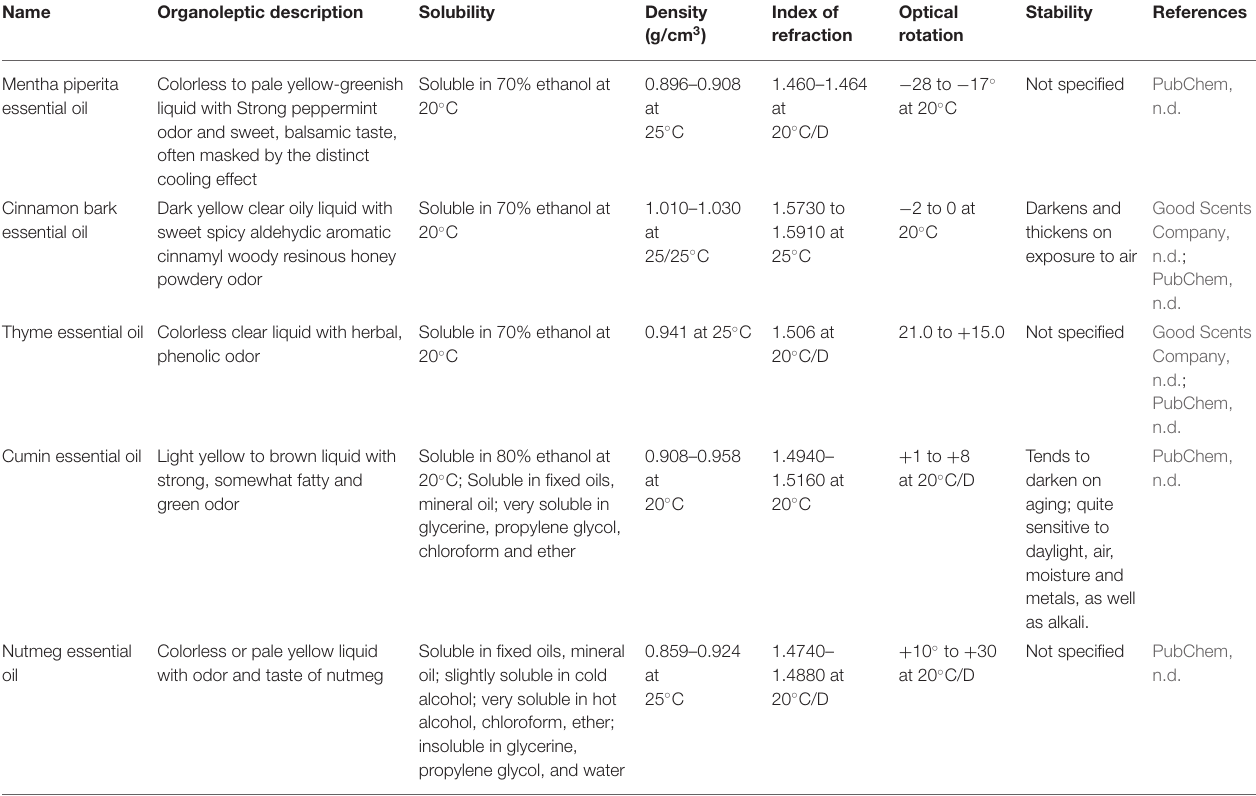
TABLE 2 | Physical characterization of selected essential